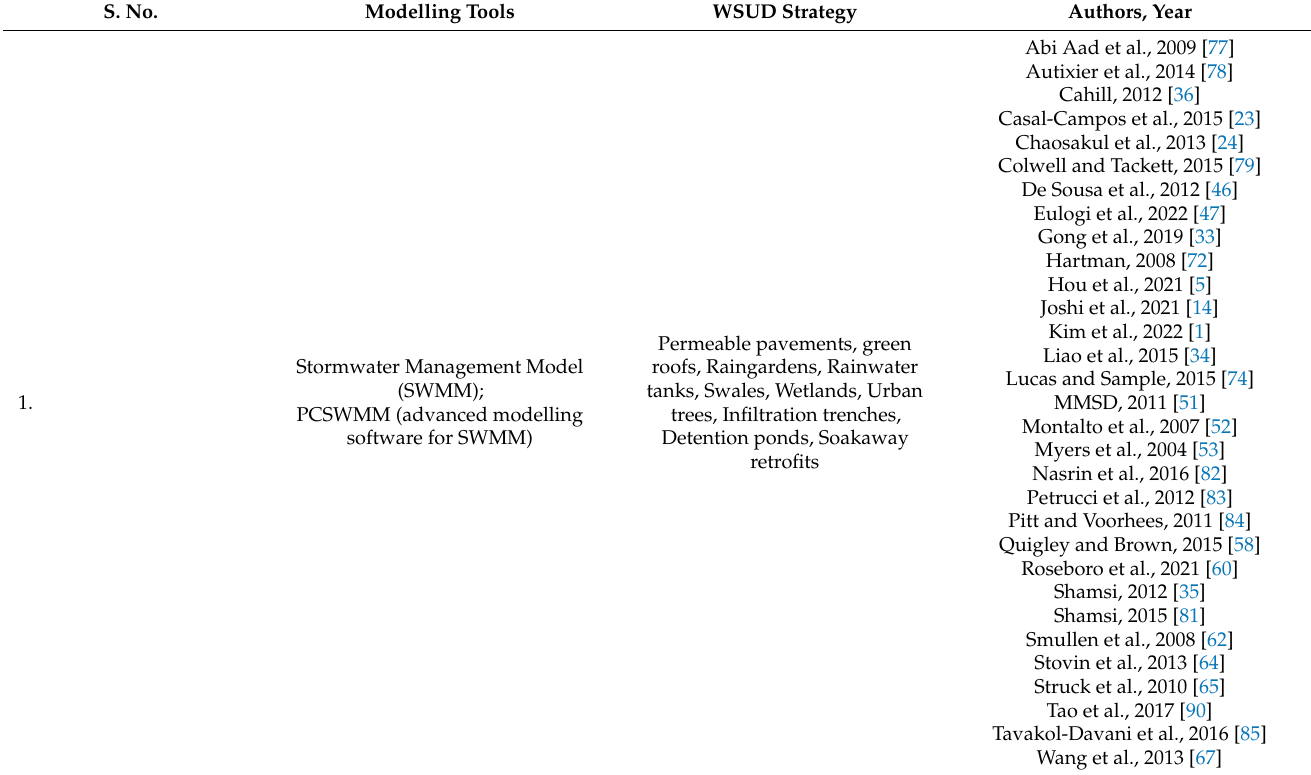
Table 3. Overview of modelling tools used for the mitigation of sewer